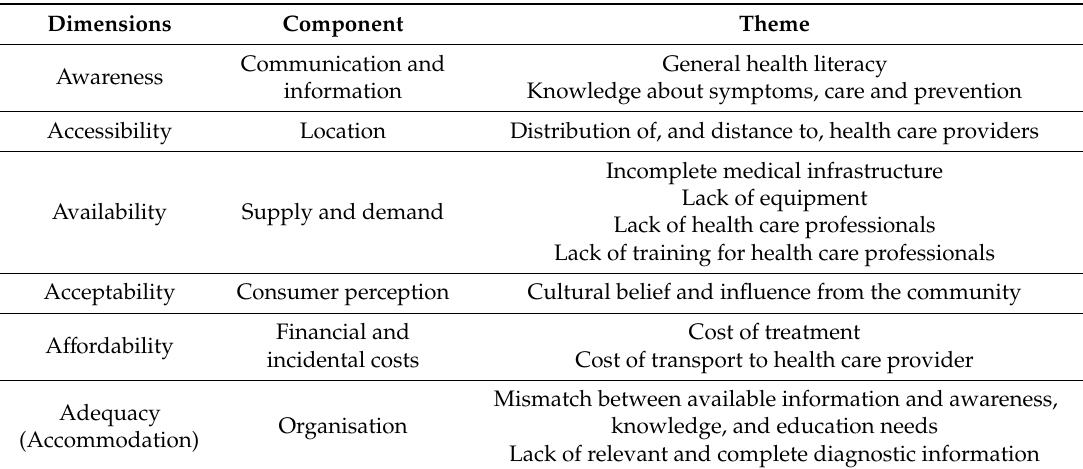
Table 2. 6A Framework of access to